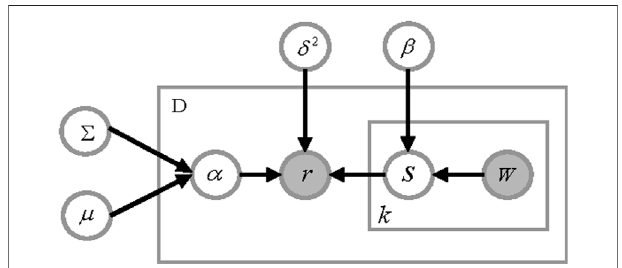
FIGURE 1 | The LRR model fl ow